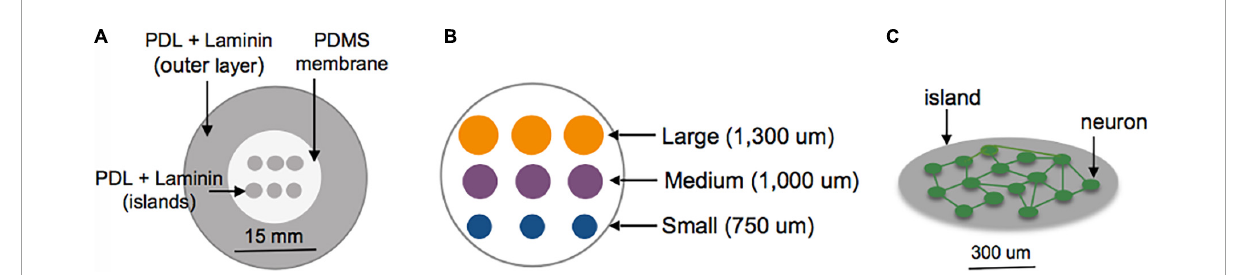
FIGURE1 Schematic of island fabrication. (A) A thin, patterned polydimethylsiloxane (PDMS) membrane was used to restrict adsorption of PDL and laminin to circular regions of the center glass area of MatTek dishes. The outer region of the dish was left uncovered to encourage diffuse attachment of neurons into a feeder layer. (B) Detailed diagram of the center glass area of a MatTek dish, patterned with a grid of islands varying in size from 750 to 1,300 um. (C) Example of patterned island with neurons allowed to develop spontaneous connections within the